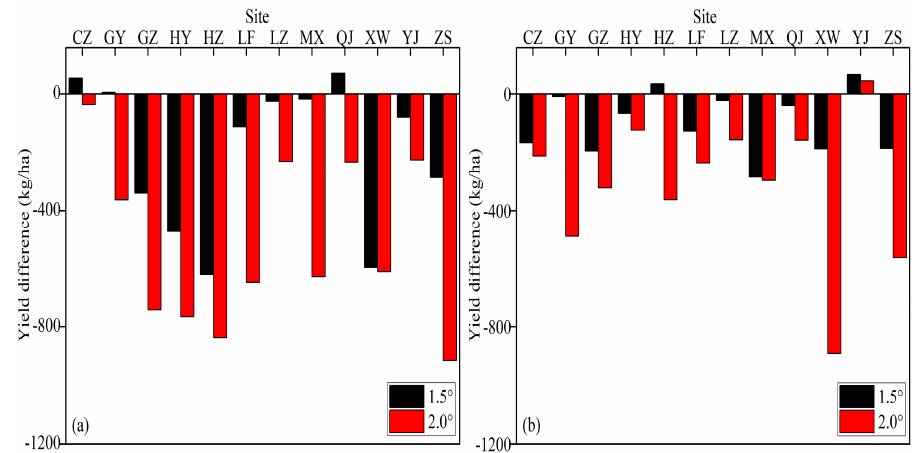
Figure 6. Changes in yields under the 1.5 and 2.0 °C warming scenarios with the CO 2 fertilization effect relative to the baseline period for the temperature. Note (a) for early mature rice and (b) for late e ff ect relative to the baseline period for the temperature. Note ( a ) for early mature rice and ( b ) for late mature rice. mature